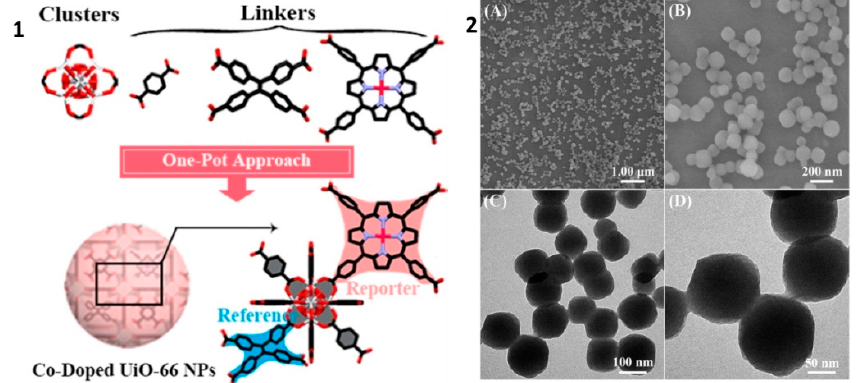
Figure 14. ( 1 ) Picture illustration for the synthesis of Pt-TCPP/H4TCPE@UiO-66NPs using one-pot in situ synthetic strategy. ( 2 ) ( A ) FESEM and the corresponding ( B ) magnified images, ( C ) TEM and the corresponding ( D ) magnified images of the Pt-TCPP/H 4 TCPE@UiO-66 NPs. The doping ratios of Pt-TCPP and H 4 TCPE to BDC in the NPs were set as 0.093:1 and 0.008:1, respectively. Reprinted with permission from [79]. Copyright 2019 Elsevier.